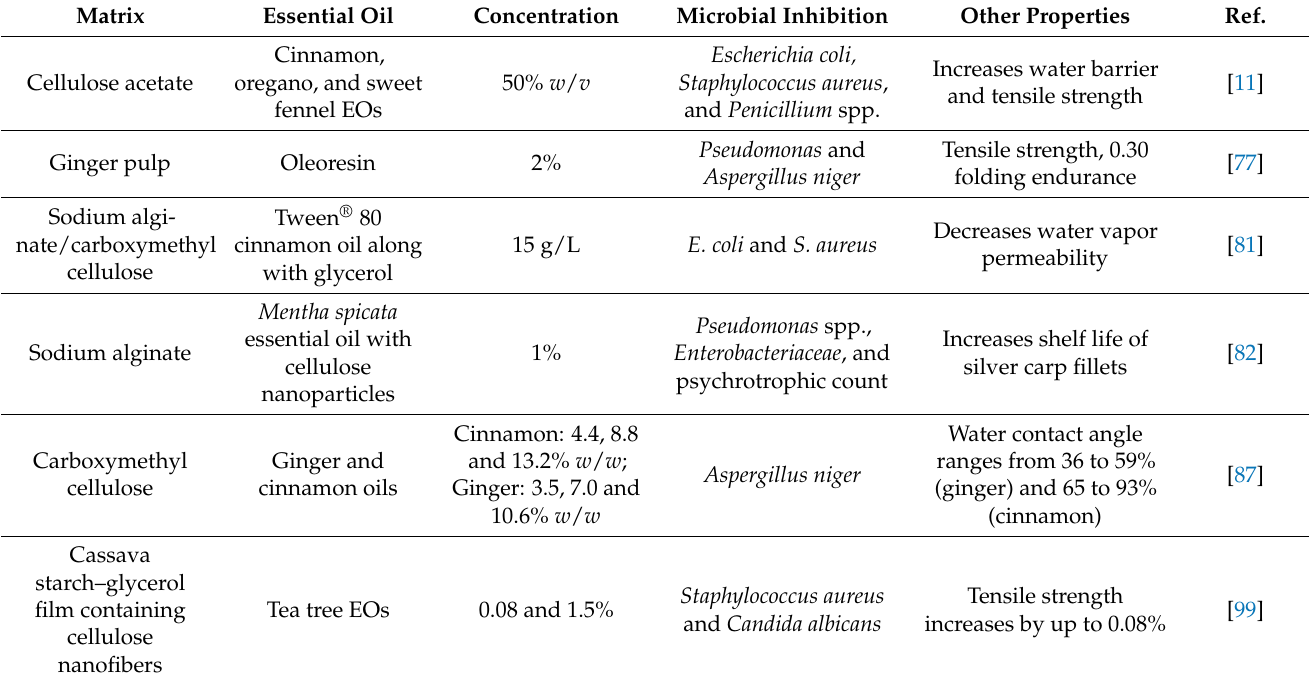
Table 2. Essential oils in cellulose-based